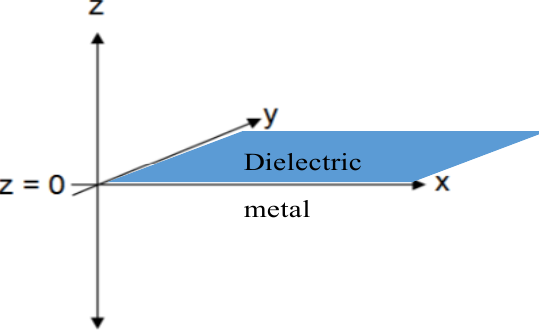
Figure 1. The coordinate system used for the description of surface